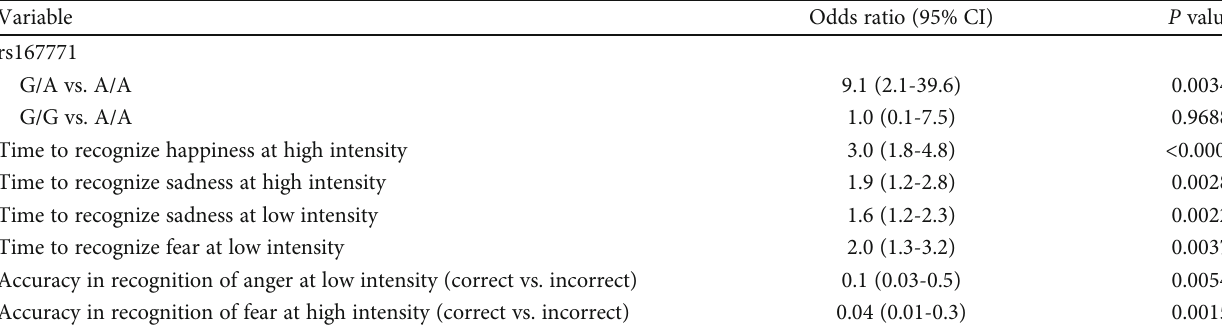
Table 5: Multivariate analysis of predictive factors associated with the risk of childhood